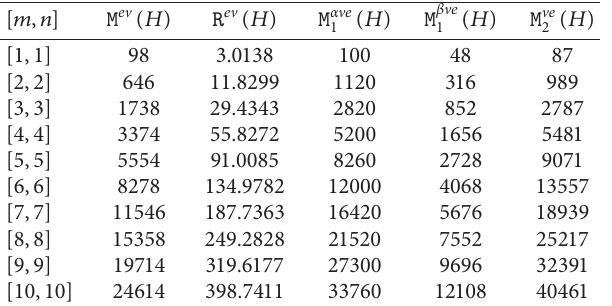
Figure 8: The Randic index. Table 8: Numerical representation of the computed indices for certain values of m and n